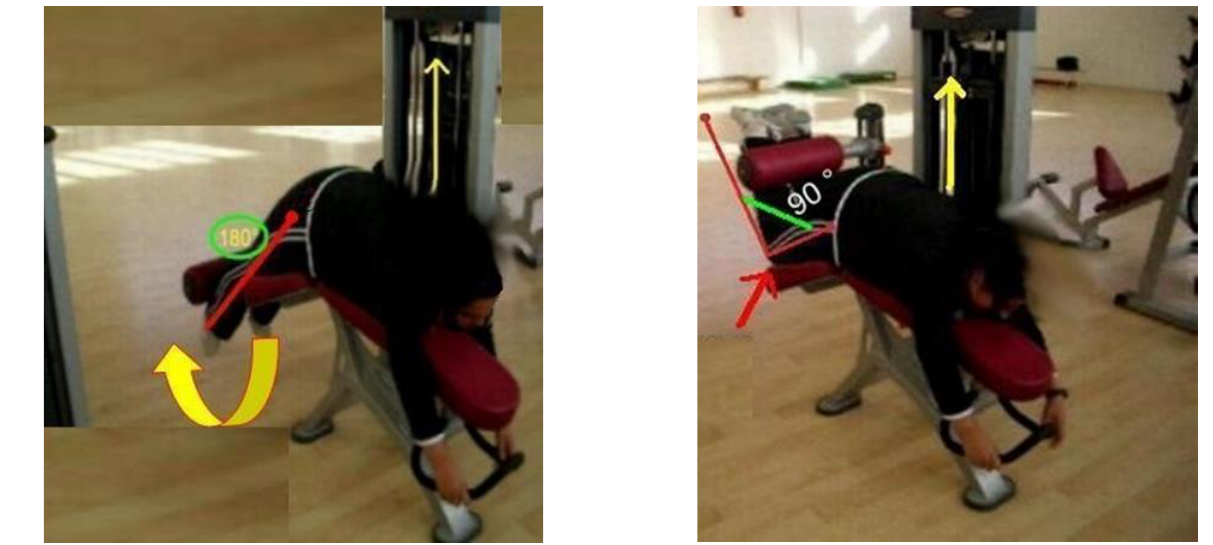
Figure 1. 1-RM prediction of knee extensor muscles.